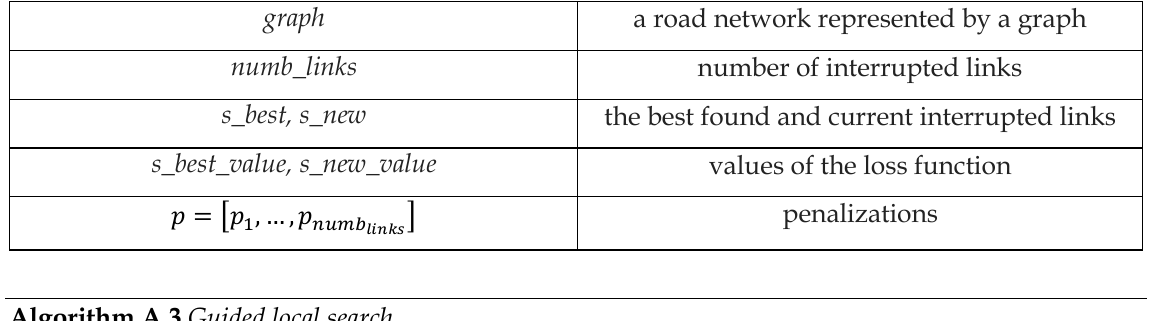
Algorithm A.3 Guided local